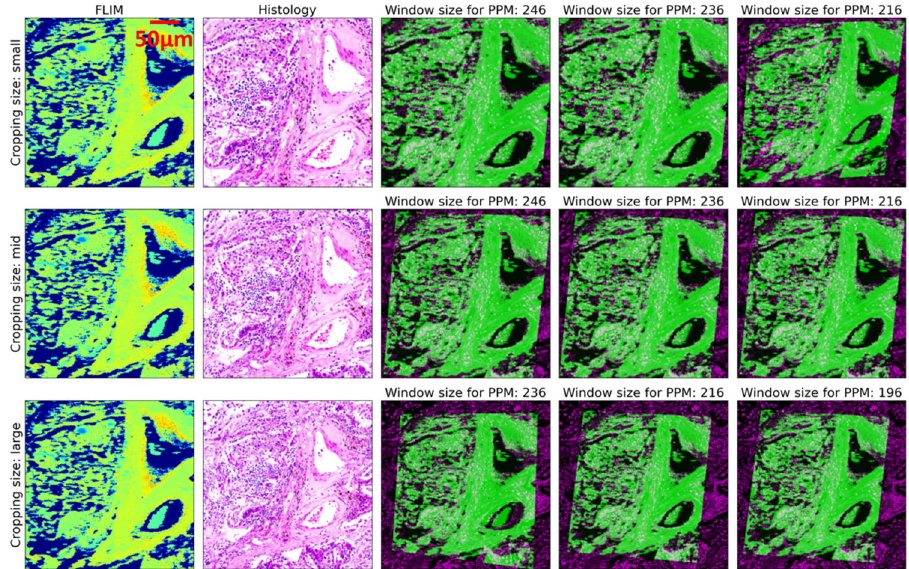
Fig. 8 Impact of the cropping size of the histological patches and the window size for PPM on the results. Three different sizes of the cropped histological patch are presented in each row, where “ small ” ( fi rst row), “ mid ” (second row), and “ large ” patch (third row) have a slightly smaller, similar, and larger FOV than the FLIM image, respectively. Three values of PPM are also evaluated and results are presented in columns three to fi